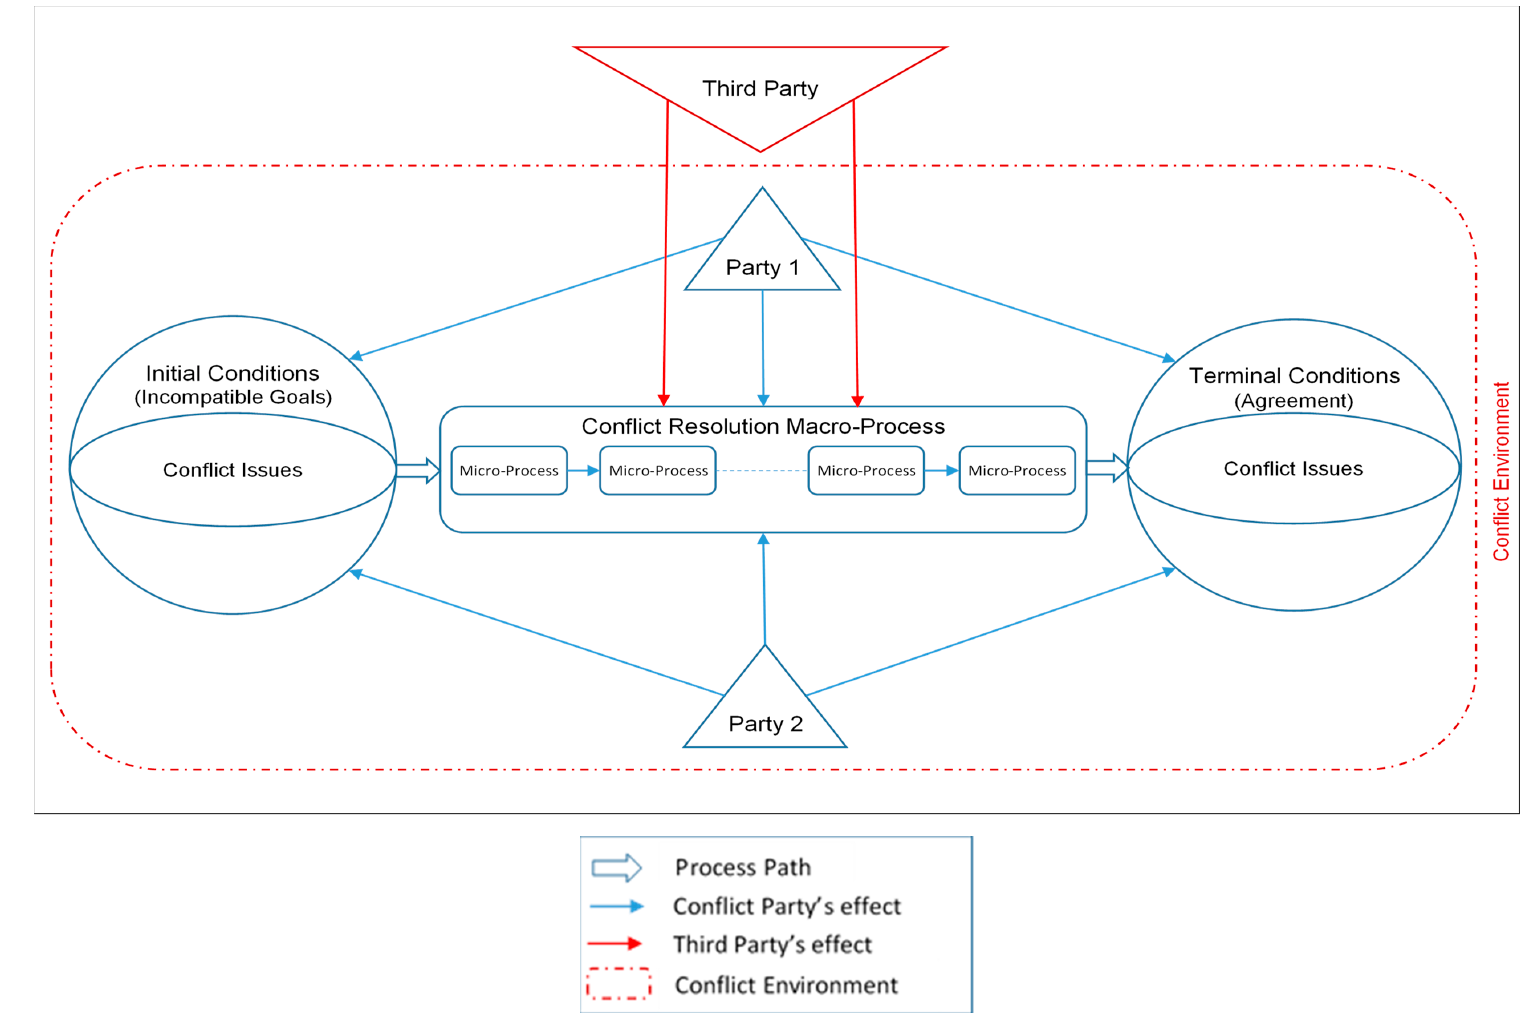
Figure 1. Conflict Resolution Mechanism Structure Used in the Study as Analytical Framework.